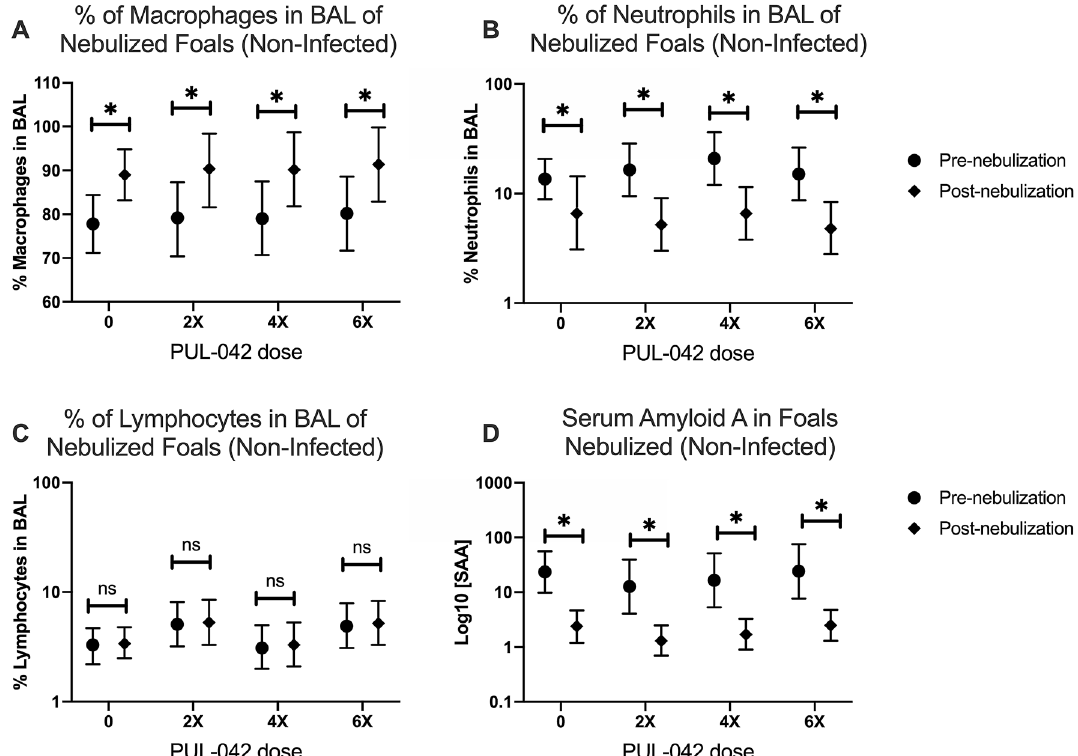
Figure 2. Broncho-alveolar lavage (BAL) fluid differential cytology ( A – C ) and serum amyloid A (SAA; ( D )) of foals either before (Pre-nebulization) or after (Post-nebulization) serial nebulization with PUL-042 at various concentrations: 0 (n = 12), 2× (n = 12), 4× (n = 12), or 6× (n = 12). All foals were nebulized and no foals were infected in vivo with Rhodococcus equi . BALs and blood collection were performed pre- (day 2 after birth) and post-nebulization (day 22, 1 day after the last nebulization). Mean is represented by the symbol (circle for pre-nebulization; diamond for post-nebulization) and 95% confidence interval (whiskers). Percentage of macrophages ( A ) in BAL increased significantly (P < 0.0001) while percentage of neutrophils ( B ) decreased (P < 0.0001) after treatment (post) in all groups. The percentage of lymphocytes ( C ) did not vary significantly. Serum amyloid A ( D ) significantly decreased post-nebulization in all groups irrespective of treatment (P <